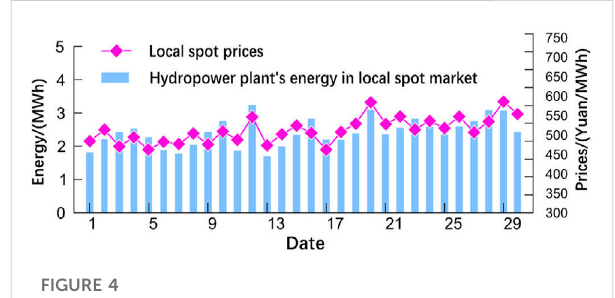
FIGURE 4 Matching analysis of hydropower plant ’ s energy in local spot market and the spot price.